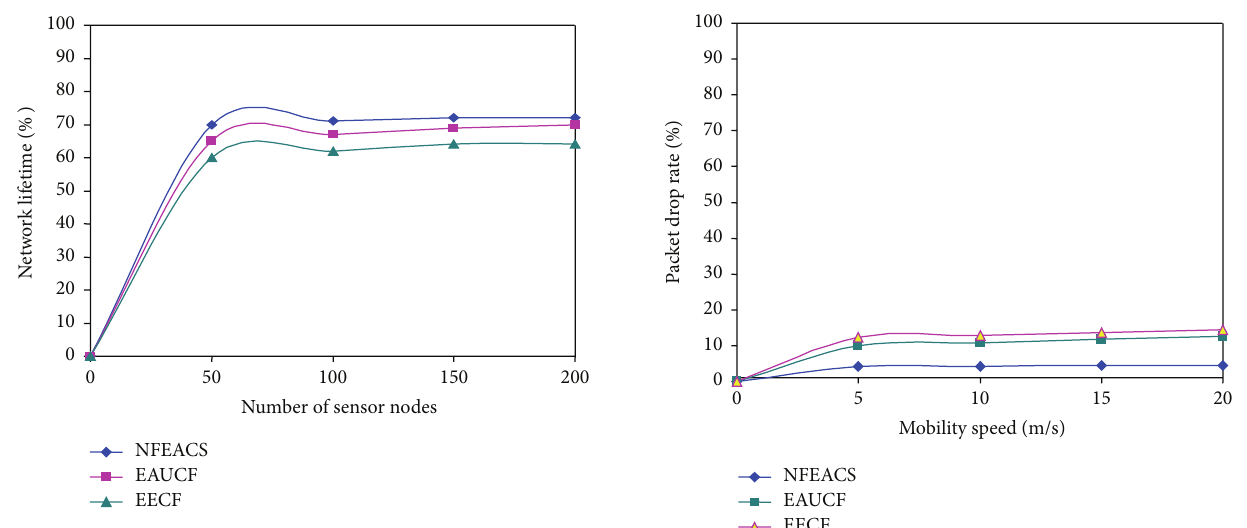
Figure 6: Network lifetime with respect to number of sensors.